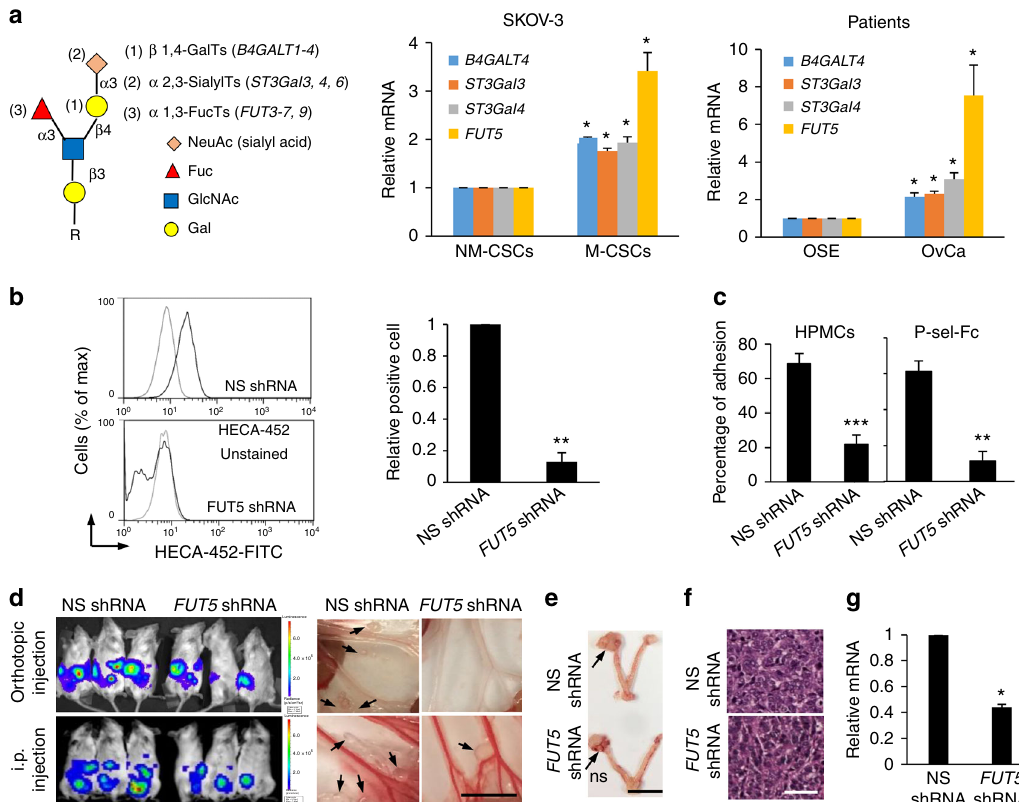
Fig. 6 FUT5 is critical for ovarian cancer progression. a mRNA expression of glycogenes related with sLe x biosynthesis. Left: schematic image indicating sLe x biosynthesis. sLe x is synthesized by sequential addition of N-acetylglucosamine (GalNAc), galactose (Gal), sialic acid (NeuAc), and fucose (Fuc) to the backbone catalyzed by N-acetylglucosaminyltransferases (GnTs), β 1,4-Galactosyltransferase ( B4GalT1-4 ), α 2,3-Sialyltransferases ( ST3Gal3, 4, 6 ) and α 1,3-Fucosyltransferase ( FUT3-7, 9 ). Middle: mRNA expression of glycogenes in M-CSCs and NM-CSCs. n = 3 per group. Right: mRNA expression of glycogenes in normal human ovarian surface epithelial (OSE) cells and M-CSCs collected from ovarian cancer patients (OvCa). n = 2 patients (OSE) or n = 4 (OvCa). Data represent as mean ± SEM, unpaired Student ’ s t test. b Detection of HECA-452 antigen on FUT5 knockdown M-CSCs. Data (mean ± SEM) from three biological replicates, n = 3, unpaired Student ’ s t test. c Percentage of FUT5 knockdown M-CSCs adhered onto HPMCs or P-selectin-Fc. n = 64/ 55, 67/35. Data (mean ± SEM) from one of three independent experiments, chi-square test. d Metastasis in mice with NS or FUT5 shRNA transduced M- CSCs orthotopic (upper) or i.p. (lower) xenograft model. Arrows: metastases. Scale bar, 1 cm. n = 3 mice (orthotopic) or six mice (i.p.). e , f Representative images e and H&E staining f of primary tumors in mice. Arrows, tumors. Scale bars = 1 cm e or 50 μ m f . g FUT5 mRNA expression of in primary tumors. n = 3 mice per group. Data (mean ± SEM) from three biological replicates, n = 3, unpaired Student ’ s t test. Experiments were conducted two d – f or three a – c , g times independently. ns, not signi fi cant. * P < 0.05. ** P < 0.01; *** P < glycosyltransferases. Ovarian cancer patients with FUT5- over- expressing tumors correlates with poorer survival compared with patients with low or no FUT5- expressing tumors. Importantly,